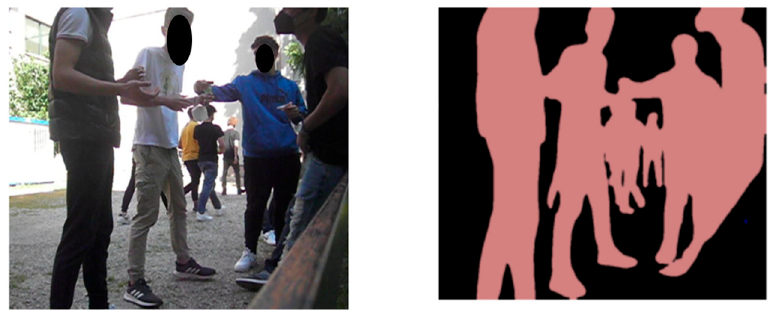
Figure 13. Original DSB image analysis using sematic segmentation.